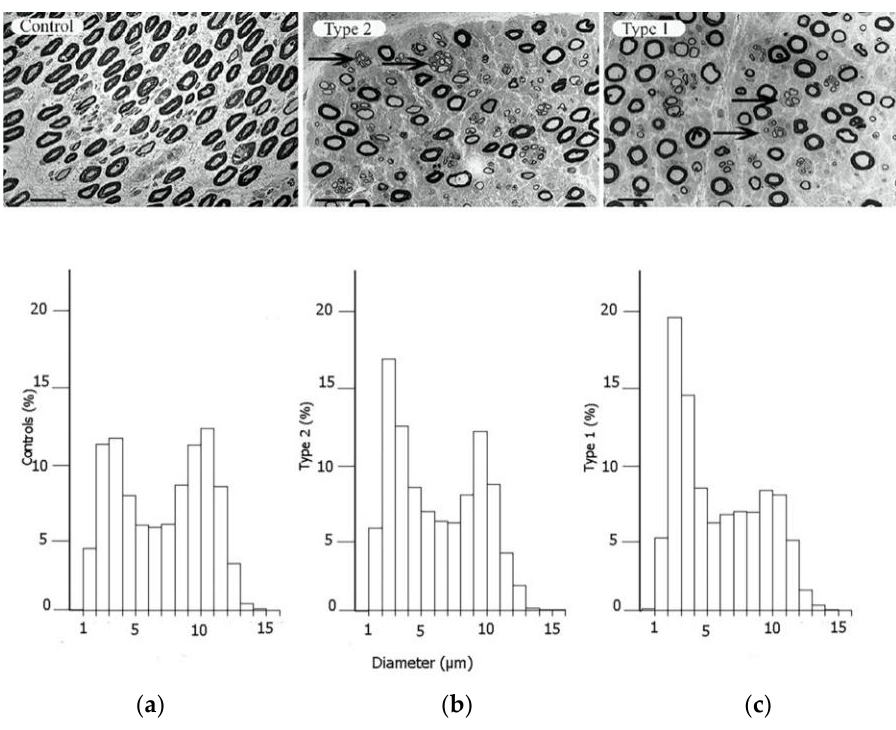
Figure 2. Electron micrographs of the posterior interosseous nerve, with diagram of size distribution of myelinated nerve fibres, from patients with CTS, where the individuals are healthy ( a ), have type 2 diabetes ( b ) or type 1 diabetes ( c ). The arrows in the upper panels indicate regenerative clusters. In the diagram on the lower panels, the size distribution of myelinated nerve fibres is based on the micrographs from the upper panels, indicating a redistribution of nerve fibres. Scale bar = 20 µm.